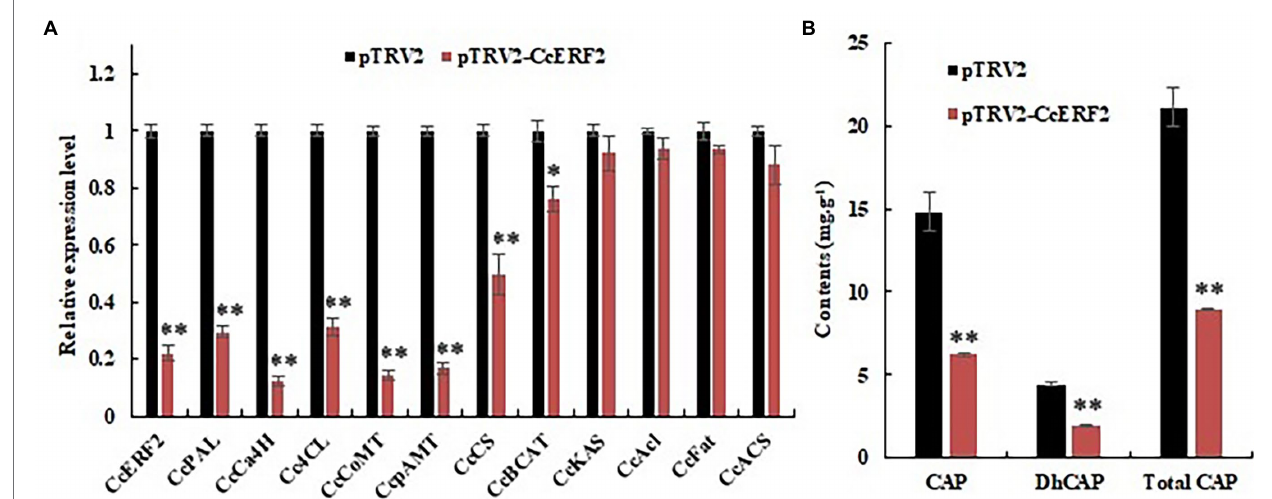
FIGURE 8 | Expression level of CBGs and CcERF2 , relative contents of CaP, DhCaP, and CAPs in the control (empty vector) and CcERF2 -silenced fruit. (A) Expression level of CBGs and CcERF2 in the control (empty vector) and CcERF2 -silenced fruit. Fruits at 24 DAP was sampled to perform the expression level of CBGs and CcERF2 . The relative expression level of the CBGs and CcERF2 in the control were set to 1, and that of in the CcERF2 -silenced fruit were measured relative to that in the control. (B) Relative contents of CaP, DhCaP, and CAPs in the control (empty vector) and CcERF2 -silenced fruit at 34 DAP. The experiments were replicated three biological times and three technical times. Data are expressed as the mean ± SD ( n = 9). Student’s t -test was used to identify significant differences compared to the control ( * p < 0.05, ** p <